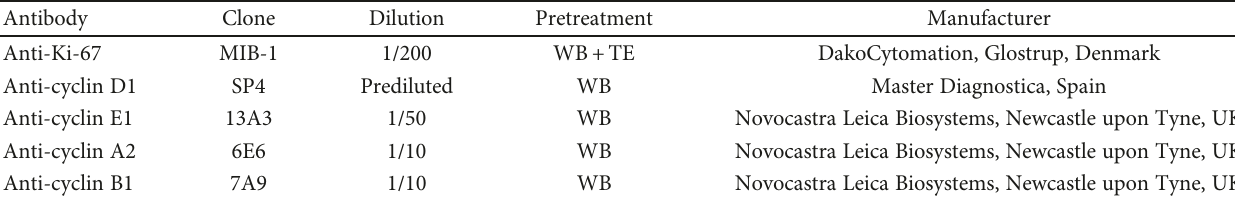
Table 2: Primary antibodies used in the present